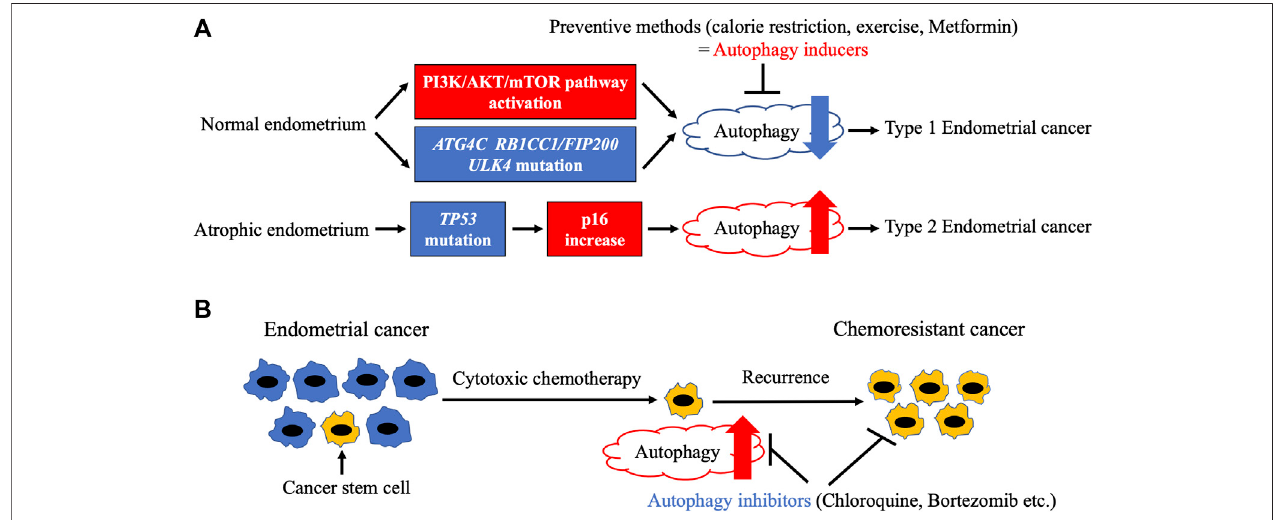
FIGURE 2 | Relationship between autophagy and endometrial cancer. (A) . Endometrial carcinogenesis and autophagy. Frequent mutations of autophagy-related genesandactivationofPI3K/AKT/mTORpathway,whichresultinautophagyattenuation,areobservedinendometrialcancer.Autophagyattenuationmayleadtotype1 endometrial carcinogenesis, indicating a potential tumor-suppressive role of autophagy inducers such as calorie restriction, exercise, and metformin. In contrast, type 2 endometrialcancerdevelopsfromatrophicendometriumdueto TP53 mutation,whichtriggersanincreaseinp16increaseandautophagy. (B) .Endometrialcancer development and autophagy. Cytotoxic chemotherapy fails to kill cancer stem cells (CSCs) with increased autophagy, leading to cancer relapse. However, autophagy inhibitors can ef fi ciently eliminate CSCs.